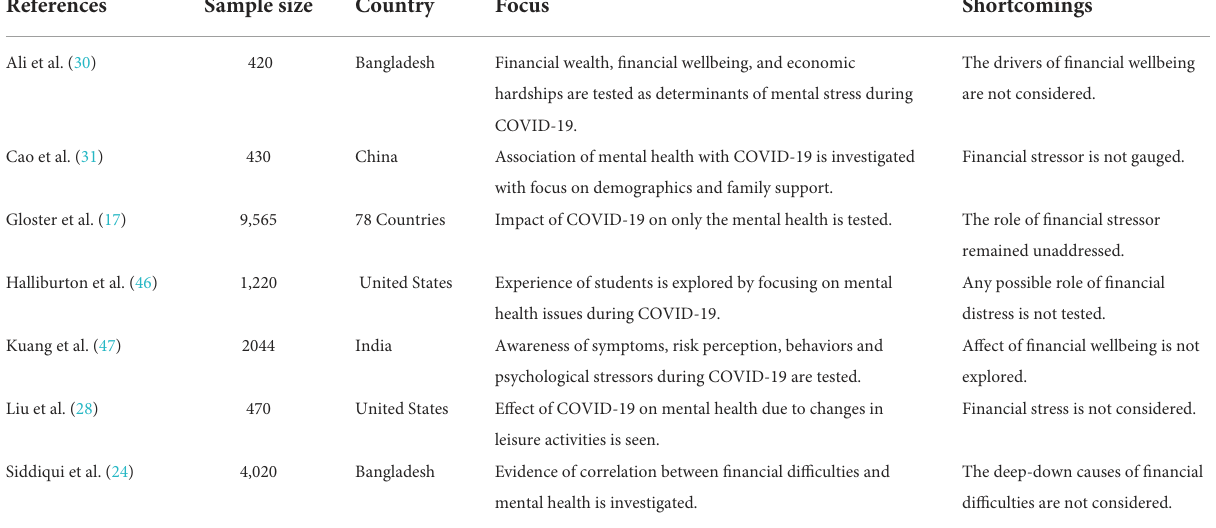
TABLE 1 Summary of literature on mental health stressors during